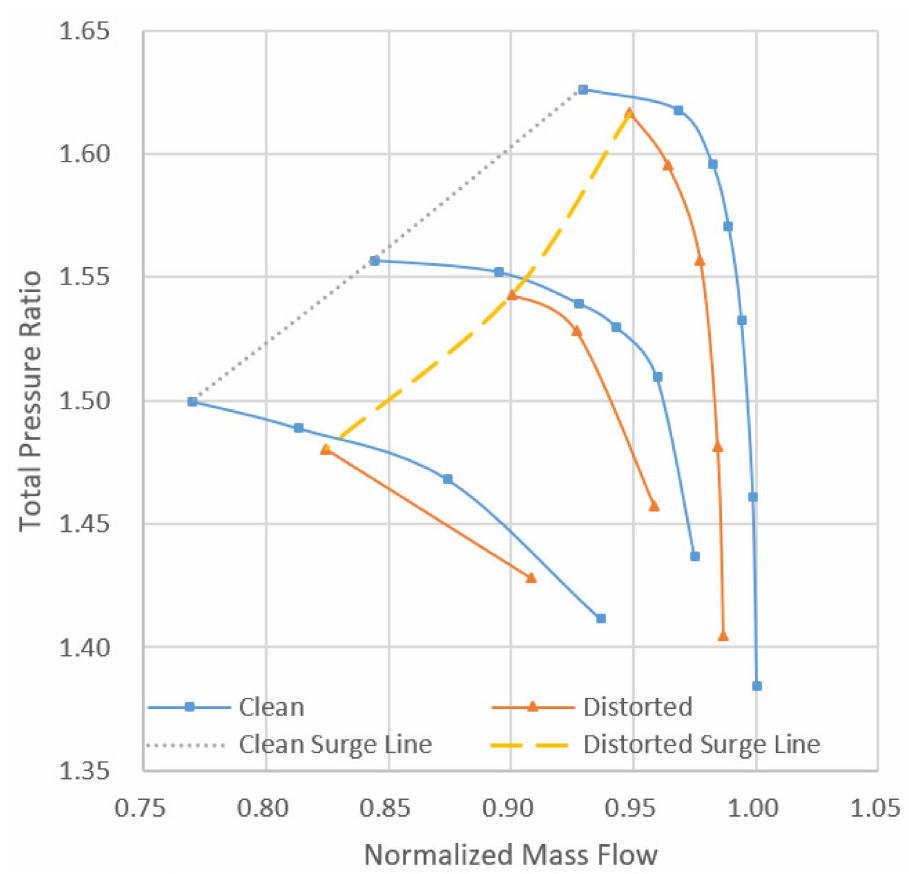
Figure 17. Clean vs. distorted performance